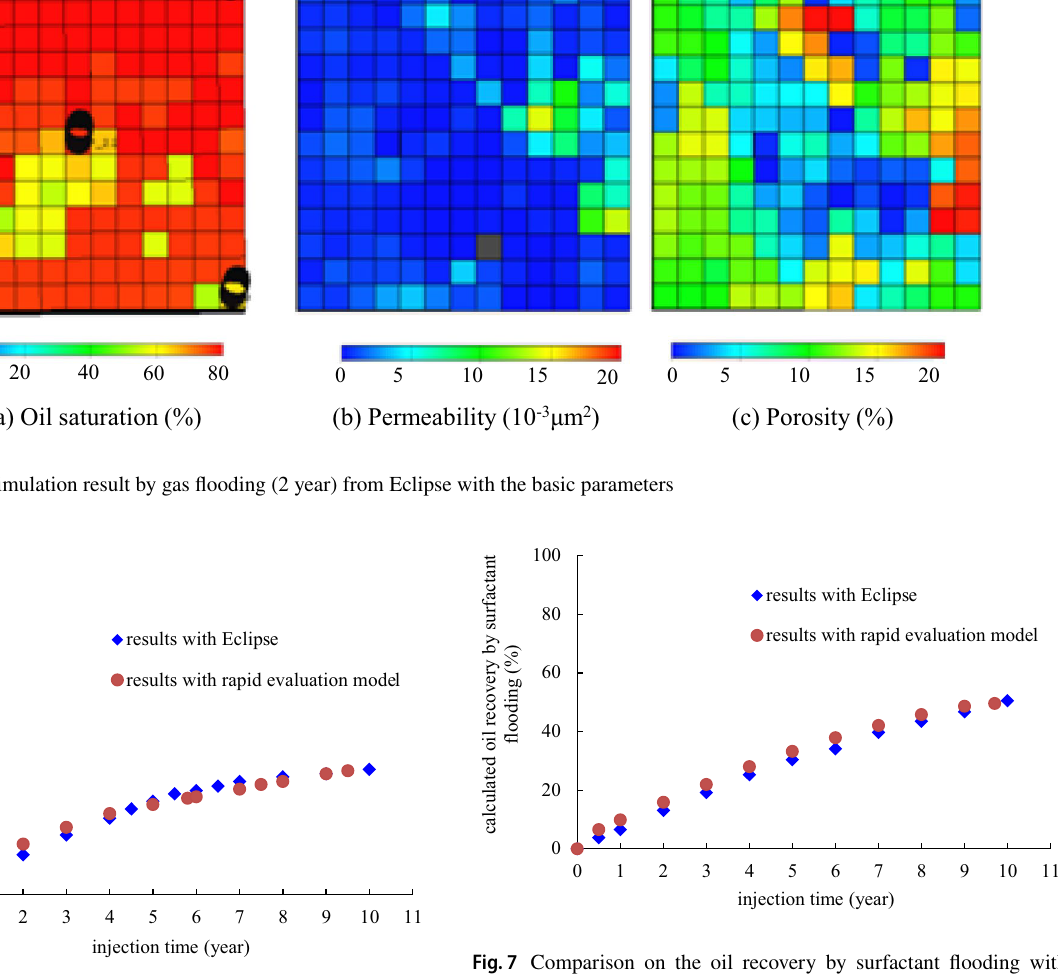
Fig. 5 Comparison on the oil recovery by gas flooding with different calculation methods